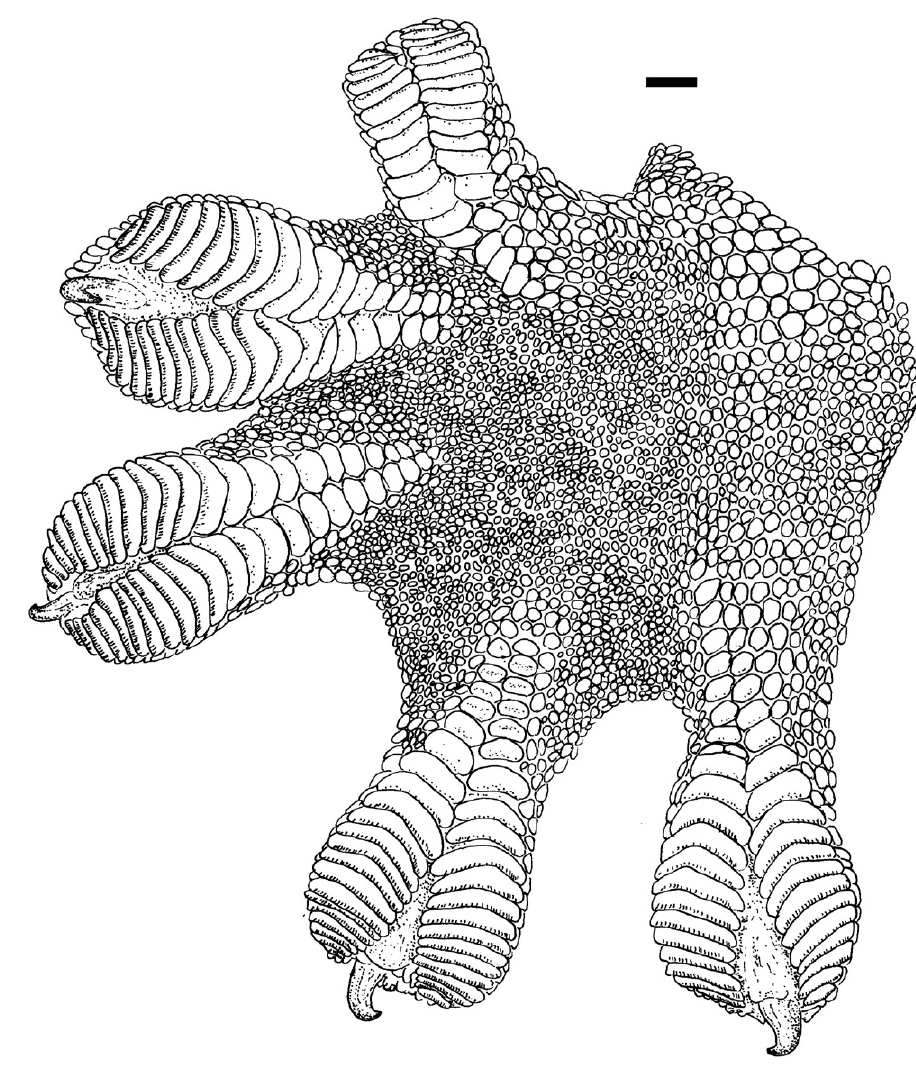
Figure 3. Right hind foot of holotype of Thecadactylus oskrobapreinorum (SMF 92120). Scale bar equals 1.0